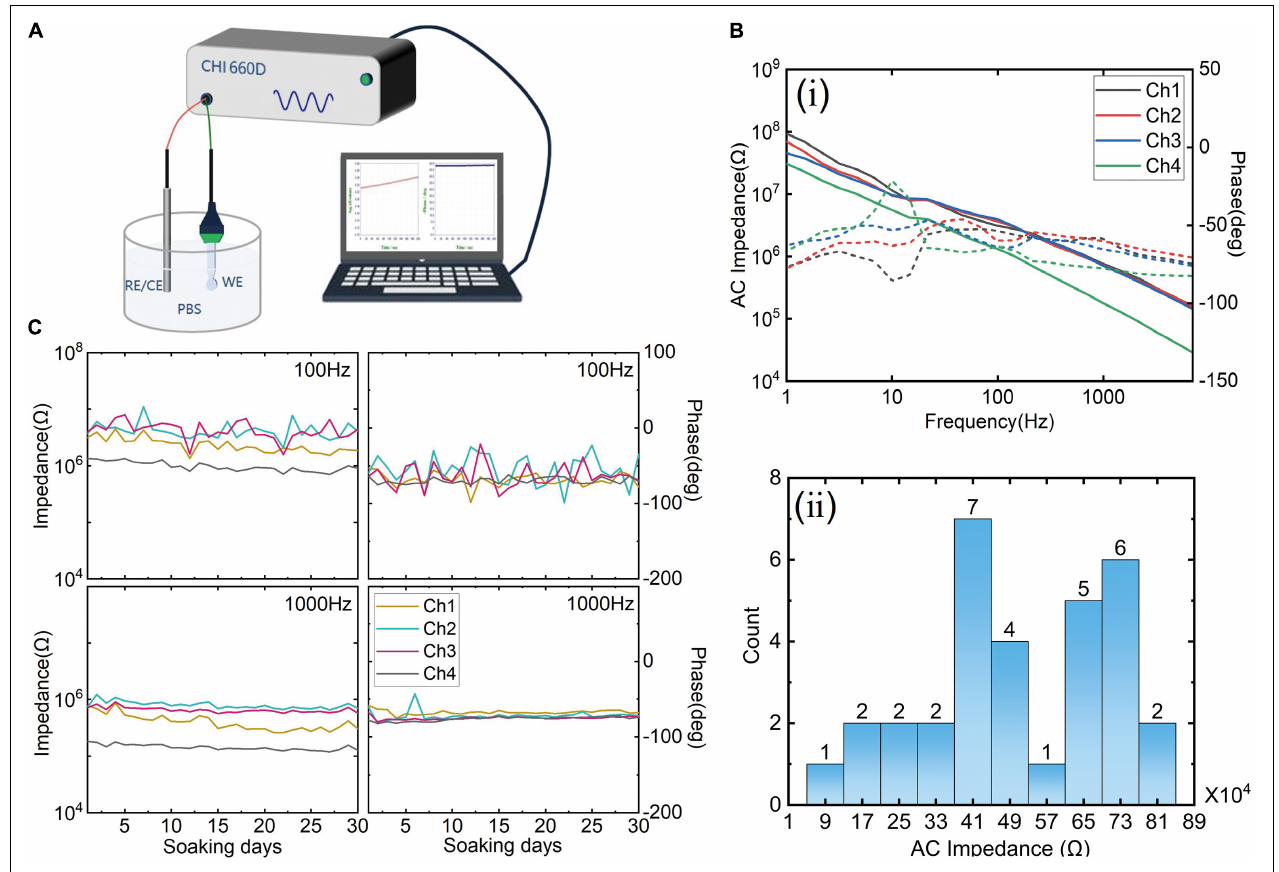
FIGURE 3 | (A) The test method schematic diagram of impedance; (B) (i) the impedance spectroscopy of one typical sample and (ii) the impedance distribution of eight probe samples with a total of 32 electrodes. (C) The aging test results of 30 days; the left column is the impedance fluctuation, and the right column is the phase fluctuation at 100 and 1,000 Hz,